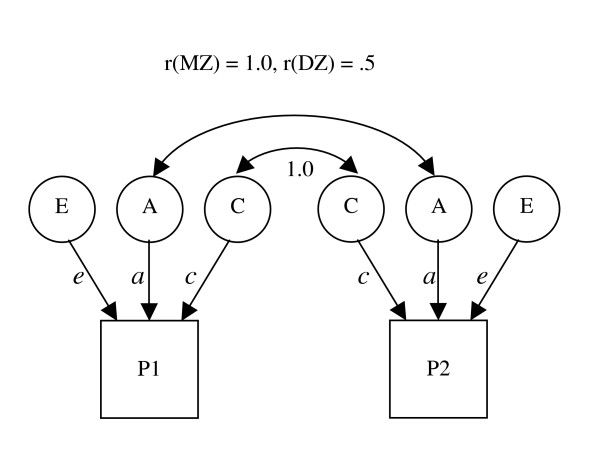
A path diagram of a univariate ACE model (A = Additive genetic factors, C = shared of common environmental factors, E = nonshared environmental effects) in which the three latent independent variables influence variation (indicated by single headed arrows) in a particular behavior or phenotype (P; P1 for twin 1 and P2 for twin 2). MZ = monozygotic; DZ = dizygotic. Partial regression coefficients (letters a, c and e) reflect the degree of relationship between the latent variables and the phenotype. Double headed arrows indicate the correlations among variables.